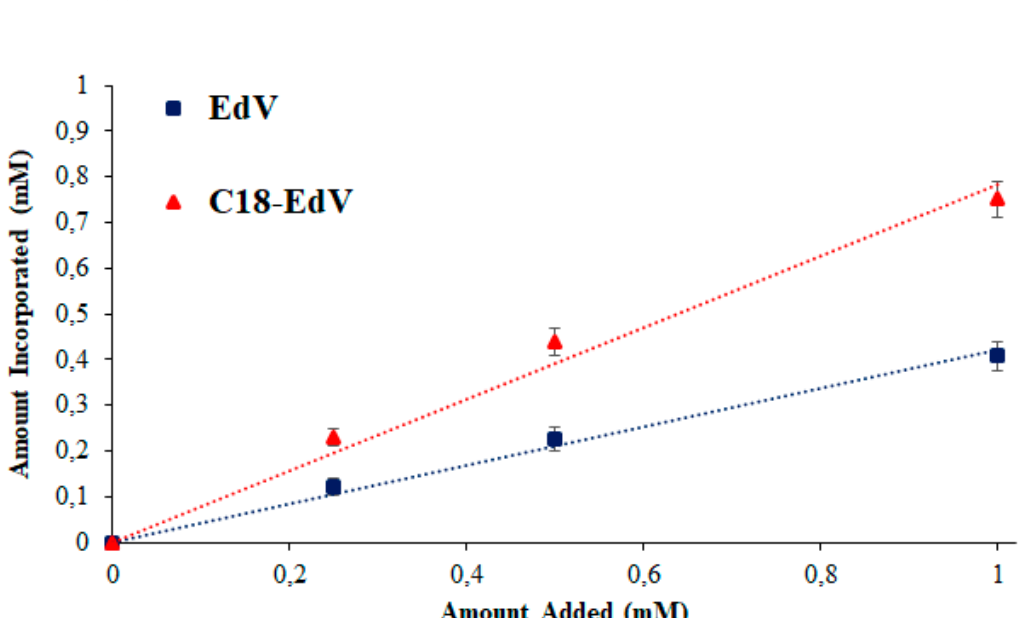
Figure 3. Amount of EdV and C18-EdV incorporated into liposomes with respect to their total amount. Increasing concentrations of EdV and C18-EdV in 0.1 mL of methanol were added to 0.9 mL of liposomal suspension. Their amount into liposomes was measured by the Folin-Ciocalteu method.